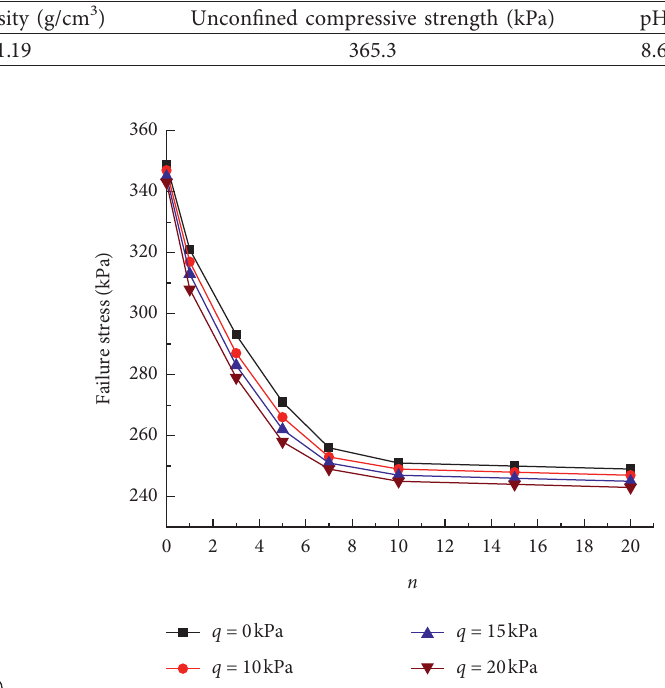
Figure 4: Relationship between peak strength of triaxial shear and dry-wet